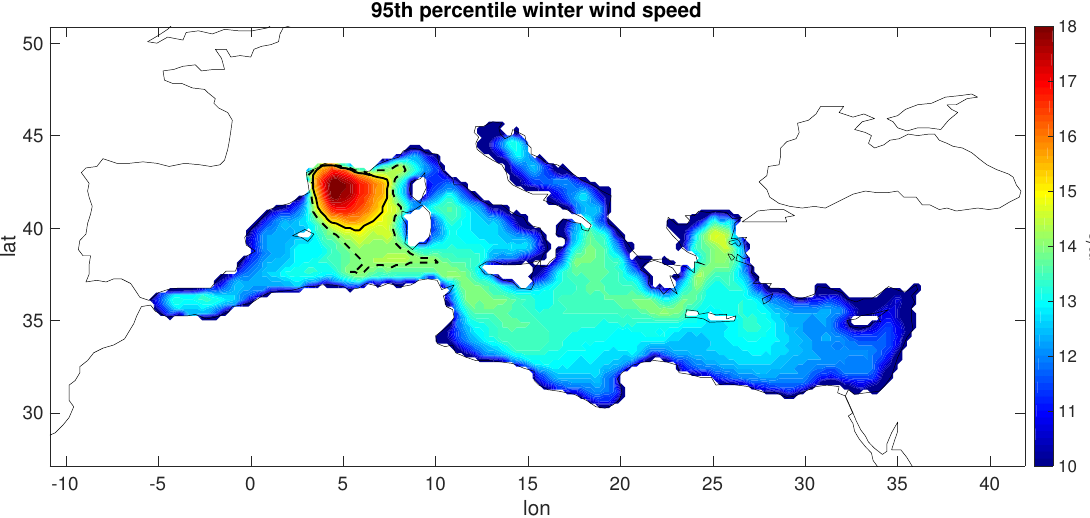
Figure 1. 95th percentile of 6-hourly winter wind intensity. The black solid line highlights the contour line at 15 ms − 1 , enclosing the region in which the analysis presented in this study has been performed. The black dashed line highlights the contour line at 14 ms − 1 , limited to the Western